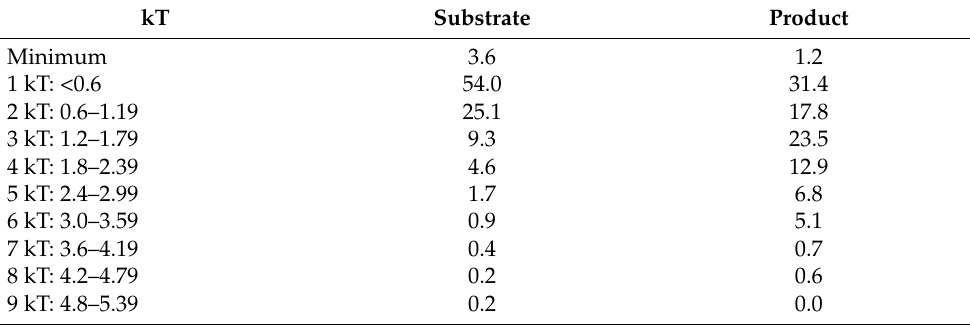
Table 2. Percentage of paired Gln147-Thr261 and Gln147-Trp153 distances for each model grouped by